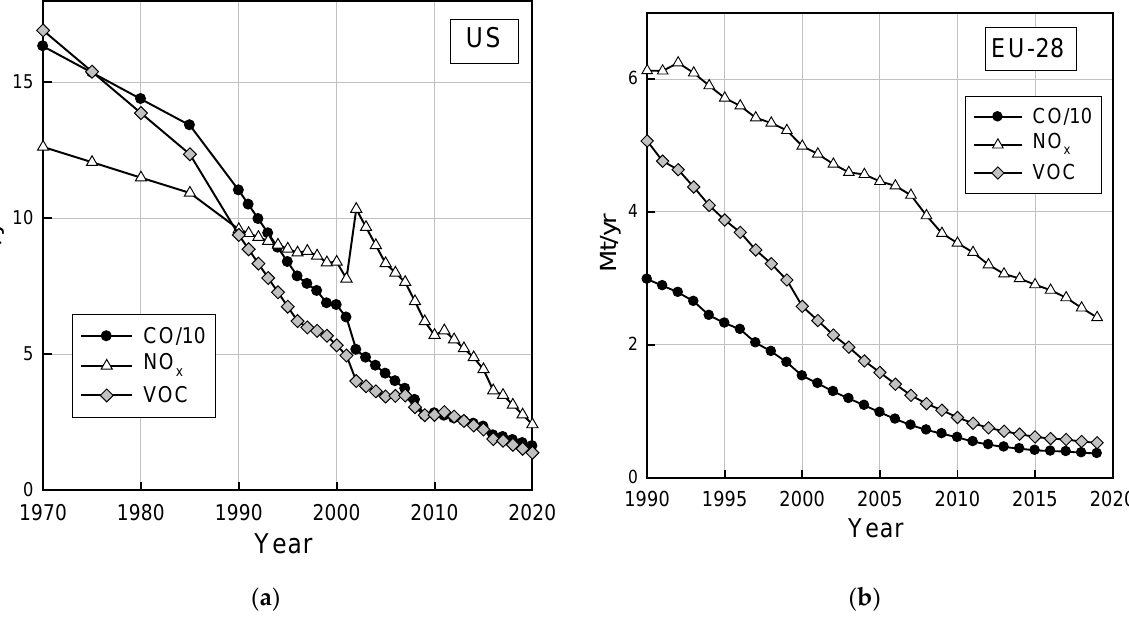
Figure 4. Total highway vehicle emissions in ( a ) the U.S. and ( b ) the EU-28, updated from Walling- ton et al. [45] see text for